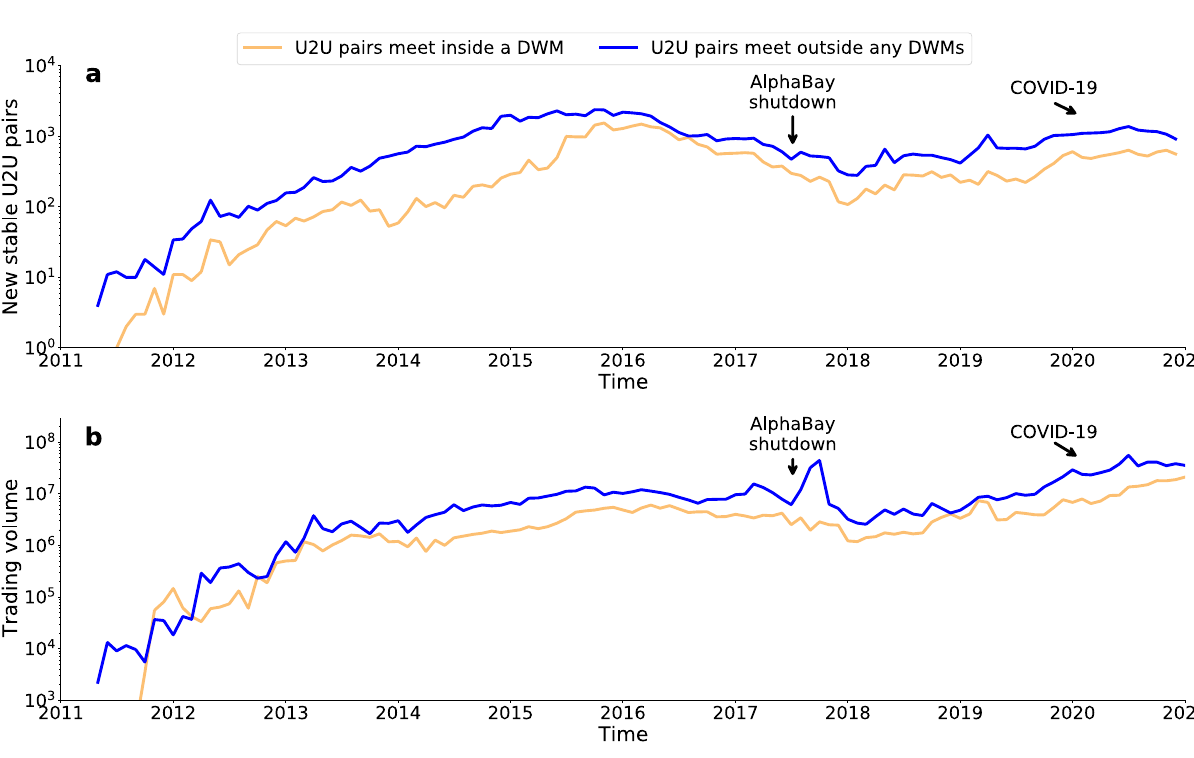
Figure 5. Temporal evolution of stable pairs. ( a ) Monthly number of new stable U2U pairs created. ( b ) Monthly trading volume of stable U2U